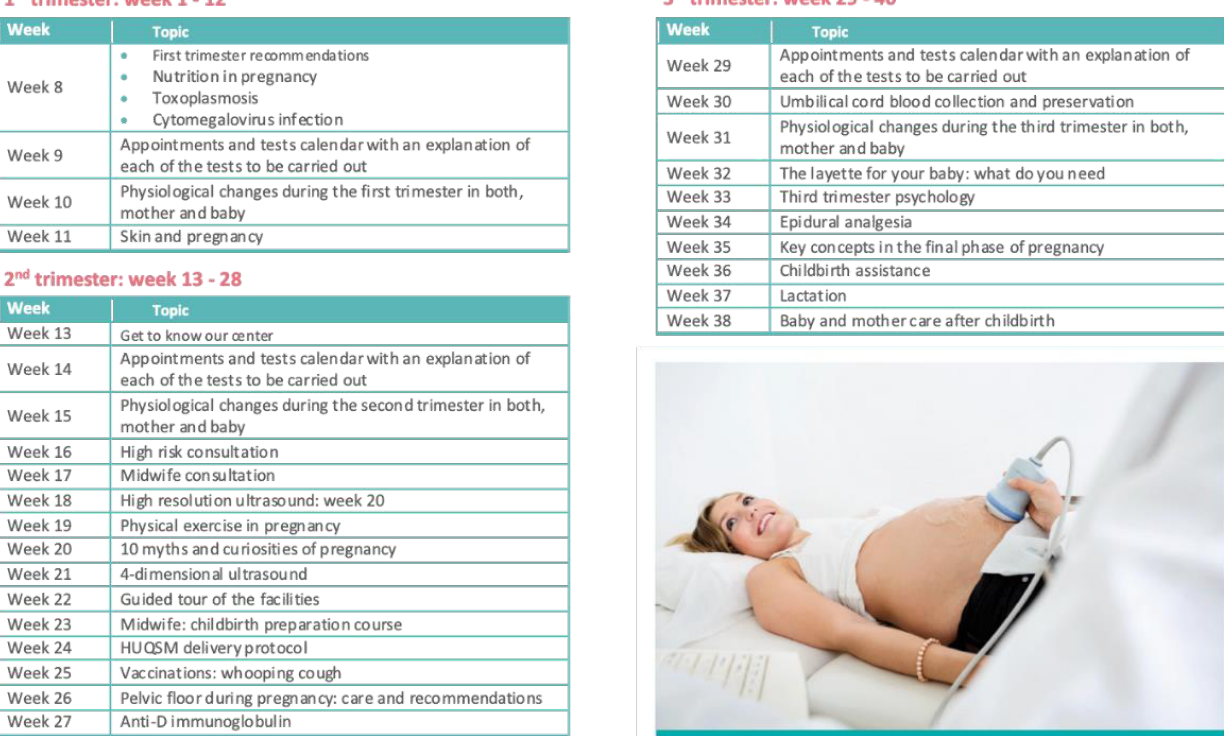
Figure A2. Flyer informing about the contents of the ‘Contigo mes a mes’ program (prepared internally and by the HUQSM marketing department).